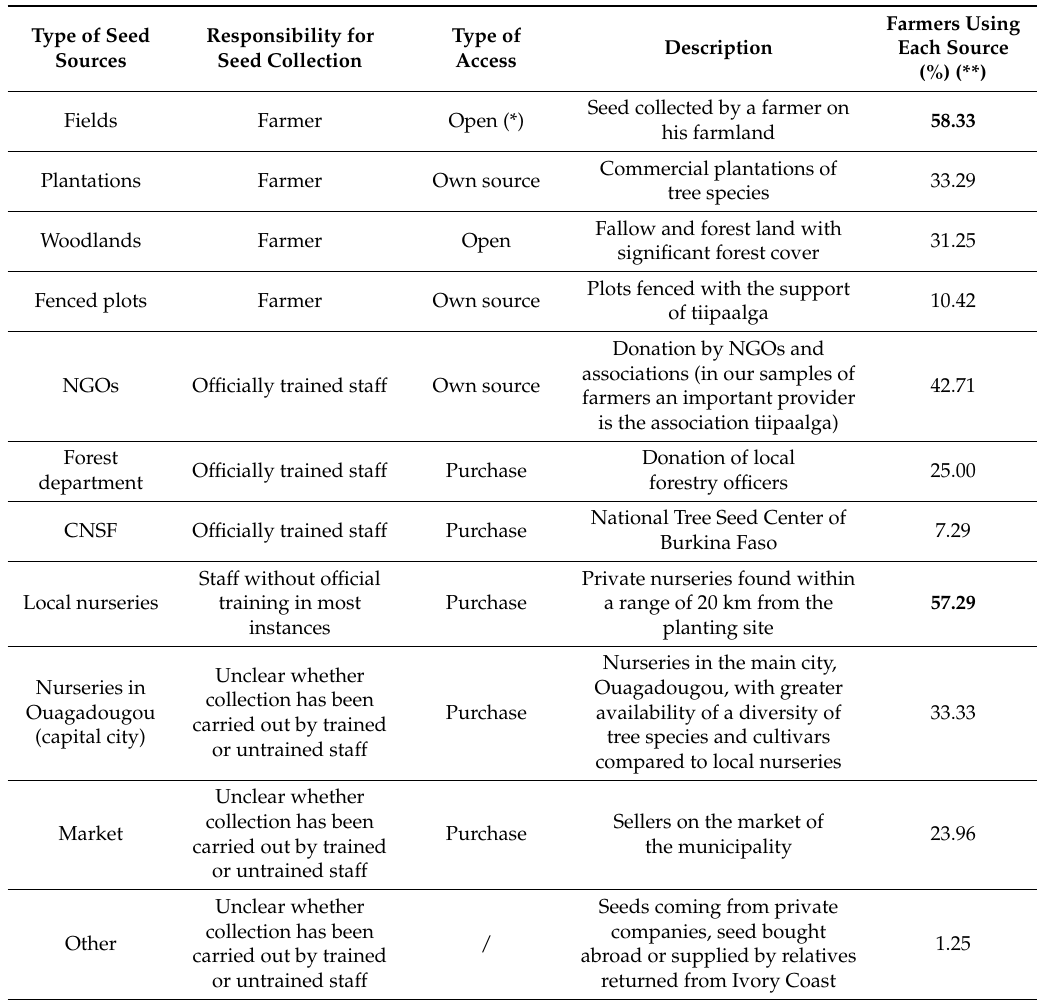
Table 5. Categories of tree seed sources used by farmers for tree planting. Seed sources are presented based on the expected level of compliance with best practices in seed collection. (*) Although trees found across farmers’ fields have a specific owner, seed collection happens almost freely; it is sufficient to ask permission to collect seed from trees on land belonging to others and this is rarely refused. (**) More than one seed source could be indicated by each farmer, so the total is more than 100%. Figures in bold have the highest values and are above